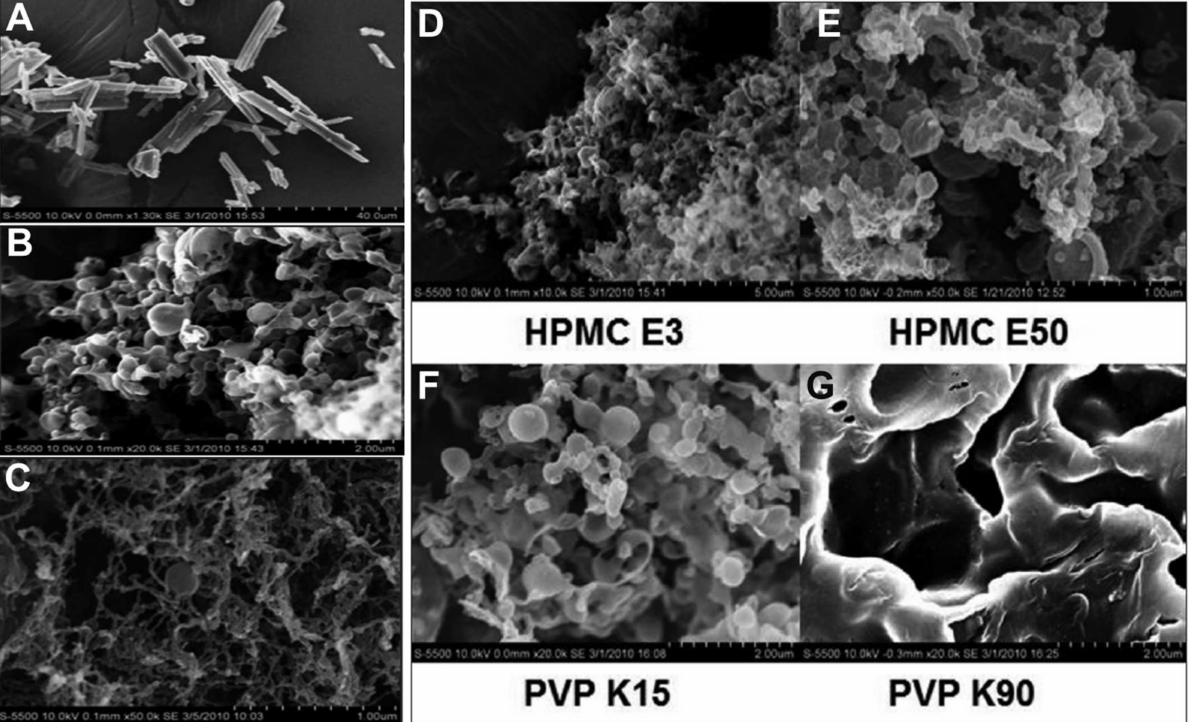
Figure 2. SEM images of ( A ) pure itraconazole (ITZ); ( B ) template emulsion-based ITZ powder; ( C ) cosolvent-processed TFF powder; and template emulsion compositions containing ( D ) HPMC E3; ( E ) HPMC E50; ( F ) PVP K15; and ( G ) PVP K90. Reproduced from Lang et al. [40] with kind permission of copyright holder,